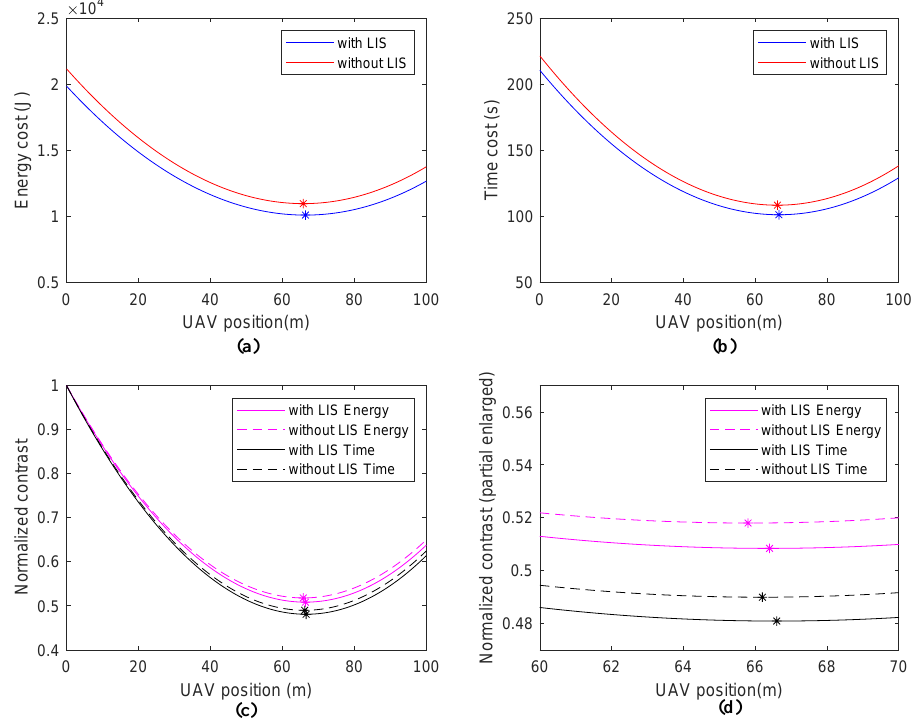
Figure 8. Simulation results of Scene II : ( a ) energy cost, ( b ) time cost, ( c ) normalized contrast, and ( d ) normalized contrast (partial enlarged).